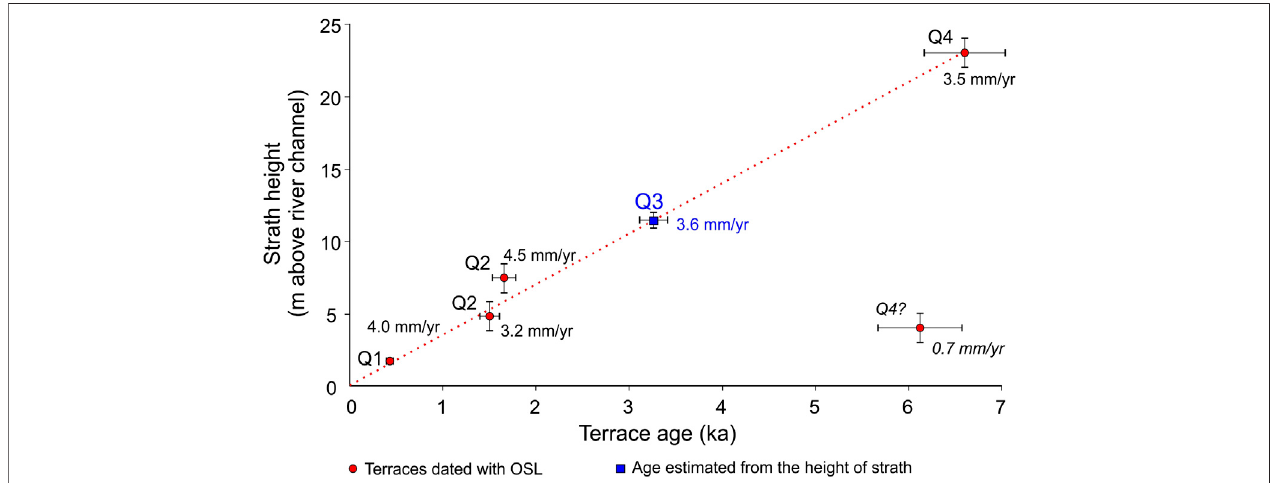
FIGURE 8 | The height of the strath in Holocene terraces along the Tecpan River plotted against terraces age.